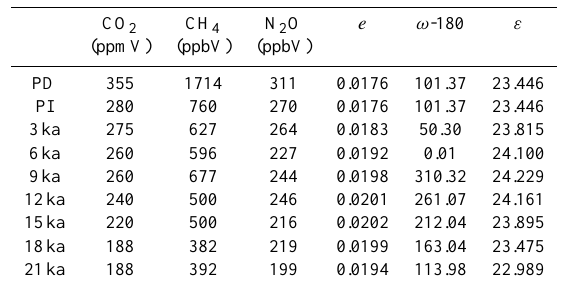
Table 1. Atmospheric greenhouse gas concentrations for each time slice simulation. The 21 through 3ka values for CO 2 (Monnin et al., 2001), CH 4 (Brook et al., 2000), and N 2 O (Sowers et al., 2003) are estimated from ice core records by averaging the gas concentra- tions within a ± 300-year window centered at the time of interest. For comparison, the PMIP3 concentrations for 6ka are 280ppmV and 650 and 270ppbV for CO 2 , CH 4 , and N 2 O, respectively, and 185ppmV and 350 and 200ppbV for 21ka. In the table, e is eccen- tricity, ω -180 is precession, and ε is obliquity (Berger and Loutre, 1991).